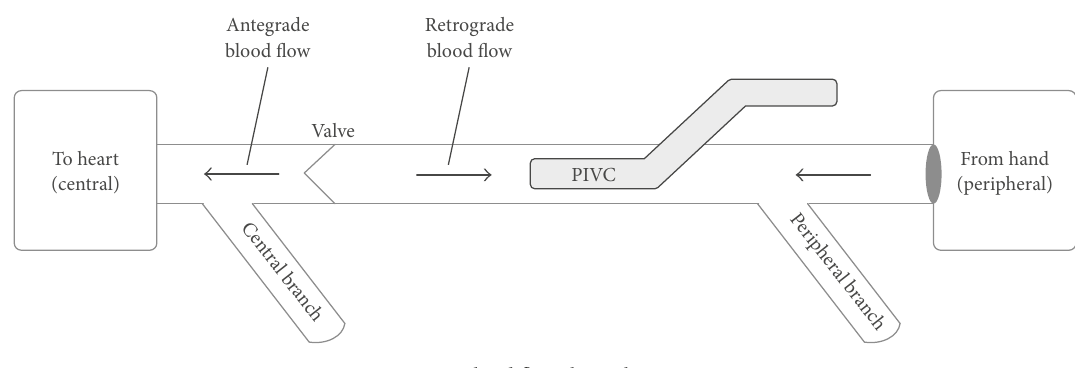
Figure 1: Blood flow through